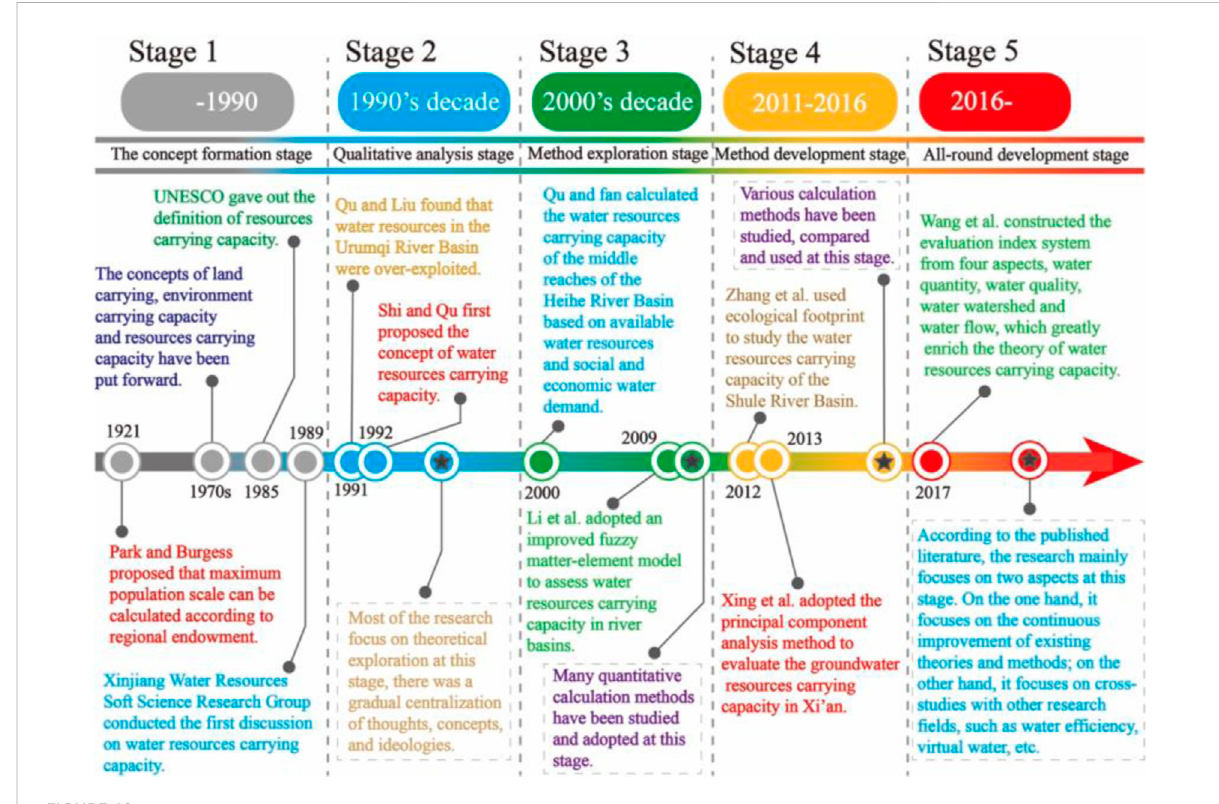
FIGURE 12 Development stages division of